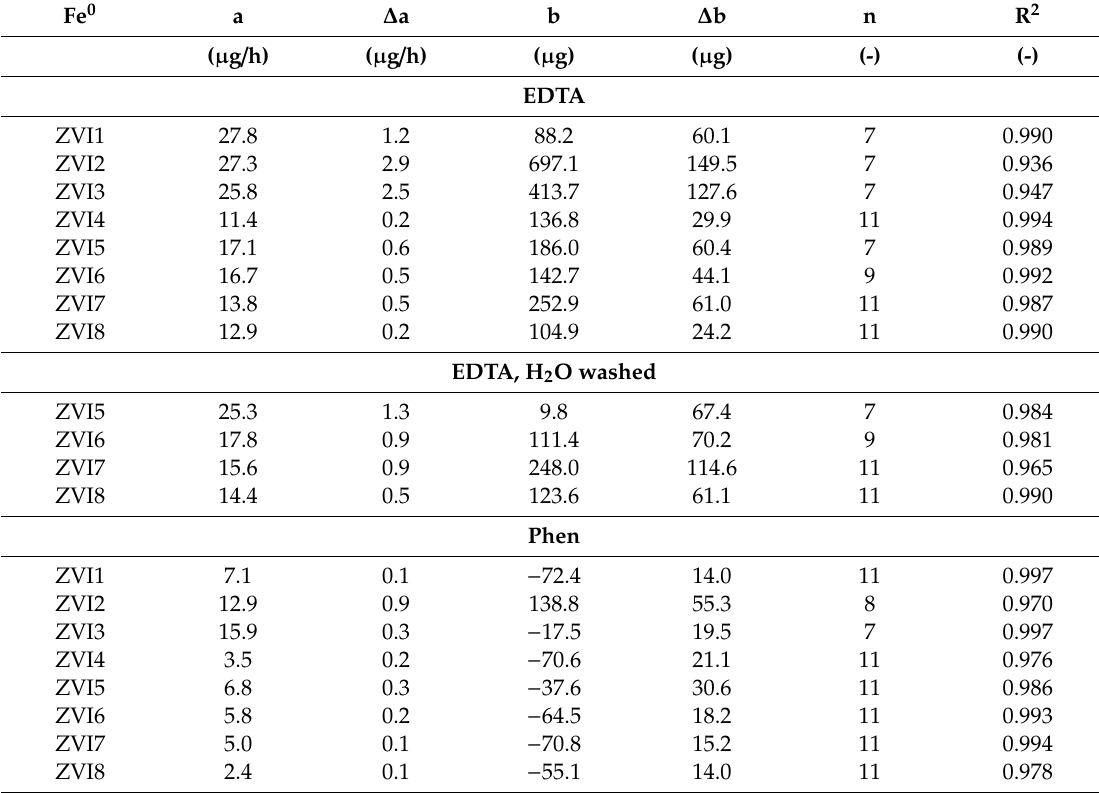
Table 3. Corresponding correlation parameters (a, b, R 2 ) for the 8 metallic iron materials. As a rule, the more reactive material is under given conditions the larger the ‘a’ value. Within the text, ‘a’ values are termed as k EDTA and k Phen for EDTA and Phen, respectively. General conditions: initial EDTA